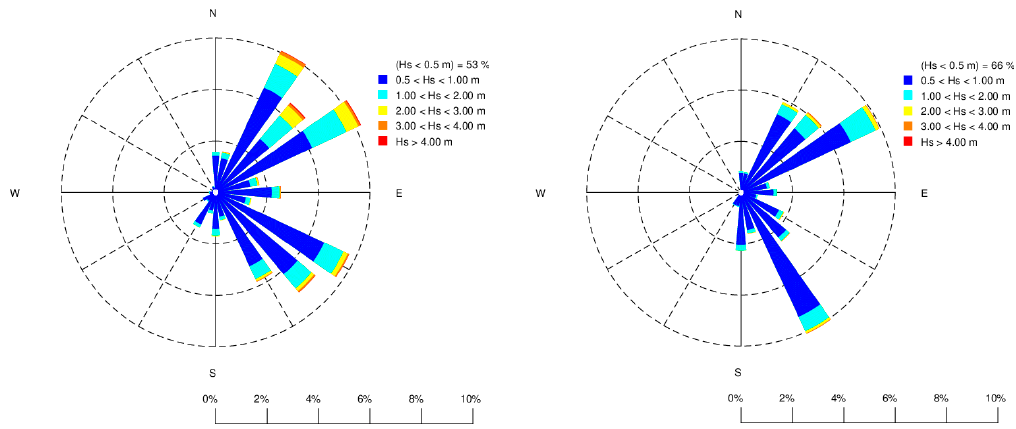
Figure 6. Offshore wave climate in the Northern Adriatic Sea: point P1 (left), point P2 (right).